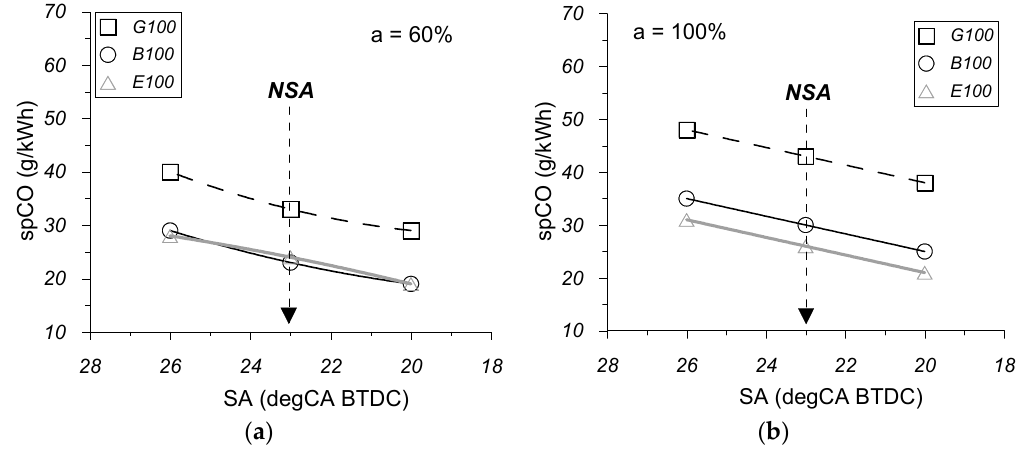
Figure 9. Variation of the calculated indicated specific CO concentration as a function of the spark advance for G100, B100 and E100 fuel operating modes, at 2400 rpm engine speed and 60% of full load ( a ); and 2400 rpm engine speed and 100% of full load ( b ).